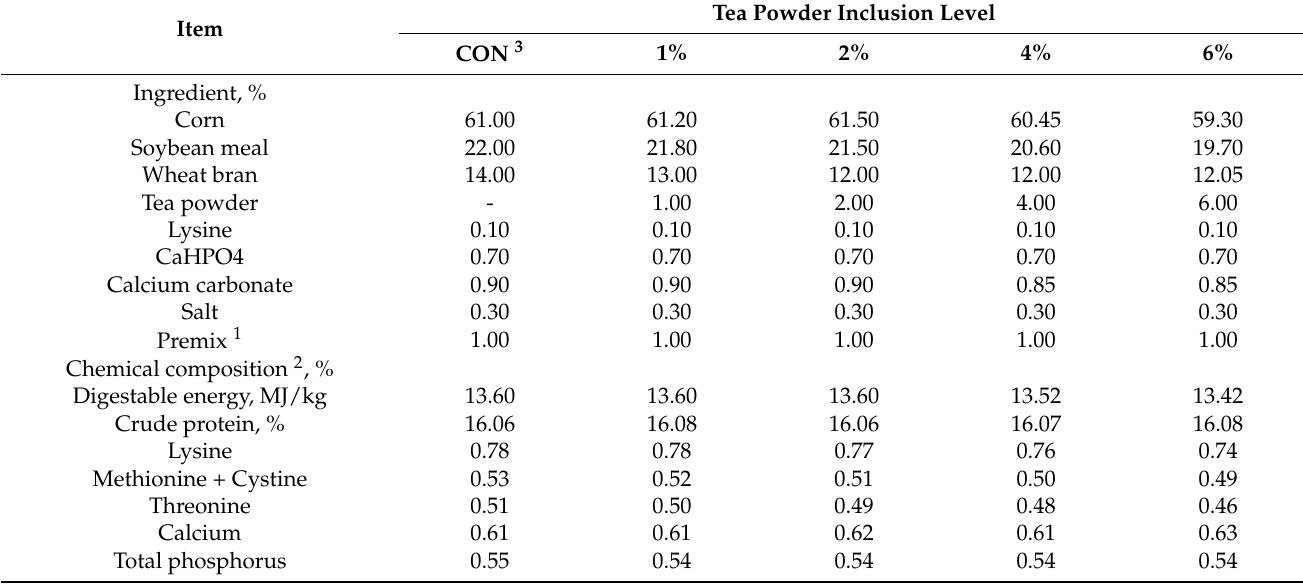
Table 2. Experimental diets composition and nutrient levels (air-dried basis,